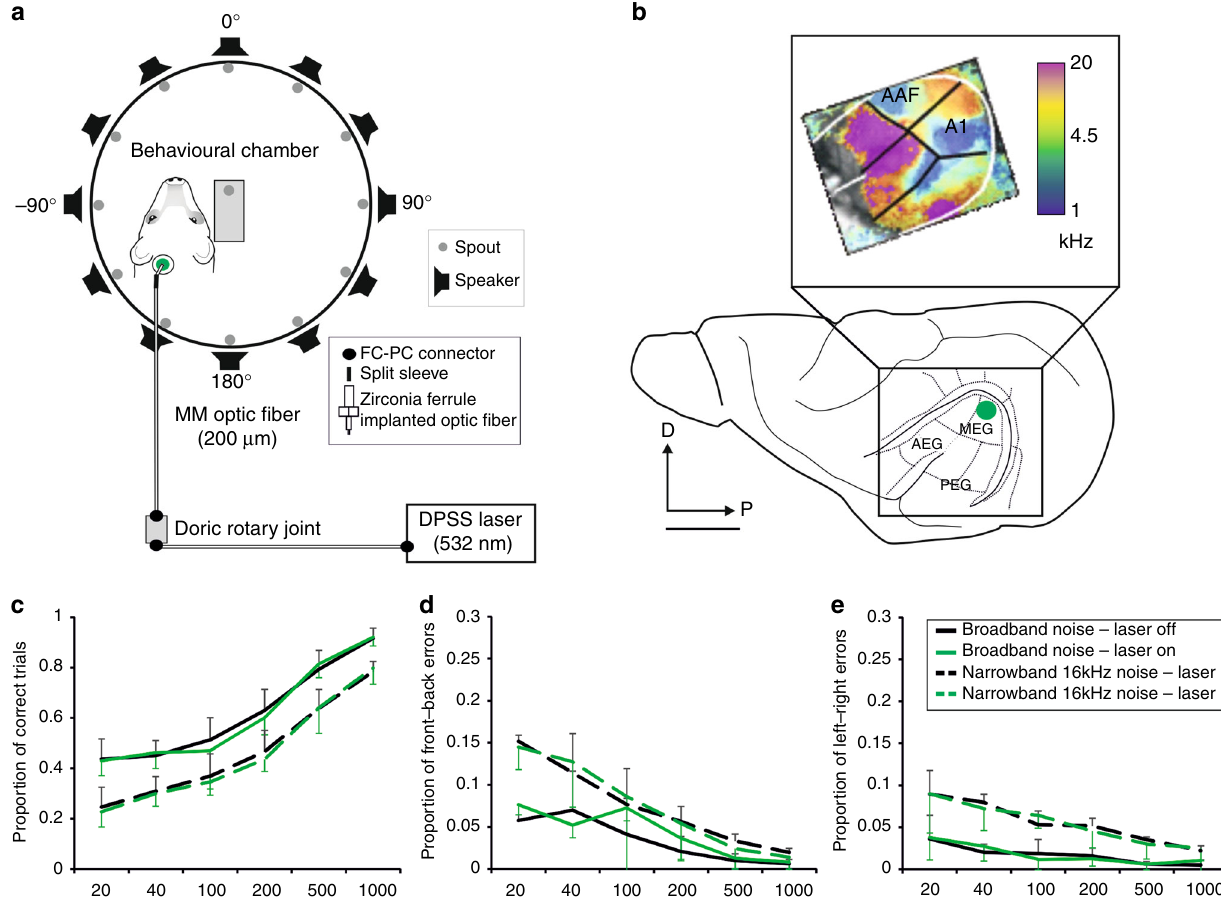
Fig. 1 Effects of unilateral optogenetic suppression on sound localization accuracy. a Floor plan of the circular chamber used for behavioral testing, with 12 loudspeakers arranged at equal intervals around the periphery. The laser was located in a locked cupboard outside the chamber from where light was transmitted by a 2.0 m long fi ber-optic cable (multi-mode fi ber, core diameter 200 μ m, 0.22 NA) connected via an FC connector to a second, 1.5 m long fi ber-optic cable at a Doric rotary joint, which was attached to the ceiling of the chamber. During each testing session, the zirconia ferrule at the end of this second cable was connected by a split sleeve to an identical ferrule in the fi ber-optic cannula implanted in the brain (Supplementary Fig. 1). The green dot indicates the location of the optical fi ber implant in the high-frequency region of A1. b The ferret auditory cortex is located in the ectosylvian gyrus and comprises three areas: the anterior, middle, and posterior ectosylvian gyrus (AEG, MEG, and PEG, respectively). The primary auditory cortex (A1) and the anterior auditory fi eld (AAF) are located in the MEG and are tonotopically organized, with neurons tuned to high frequencies (warm colors, inset) found in the dorsal corner of each fi eld and neurons tuned to lower frequencies located more ventrally (cool colors). The inset shows the frequency map of one animal obtained using intrinsic optical imaging 66 . D, dorsal, P, posterior. Scale bar, 5 mm. c – e Sound localization accuracy was not affected by unilateral optogenetic suppression of A1 activity ( n = 13). Two different sound stimuli, broadband noise and one octave narrowband noise centered at 16 kHz, were presented at six different durations (20 – 1000 ms) to examine the effects of suppression of activity in the high-frequency region of A1 in 50% of trials (randomly interleaved). c Proportion (mean ± s.d) of correct responses, d front – back errors, and e left – right errors. Source data are provided as a